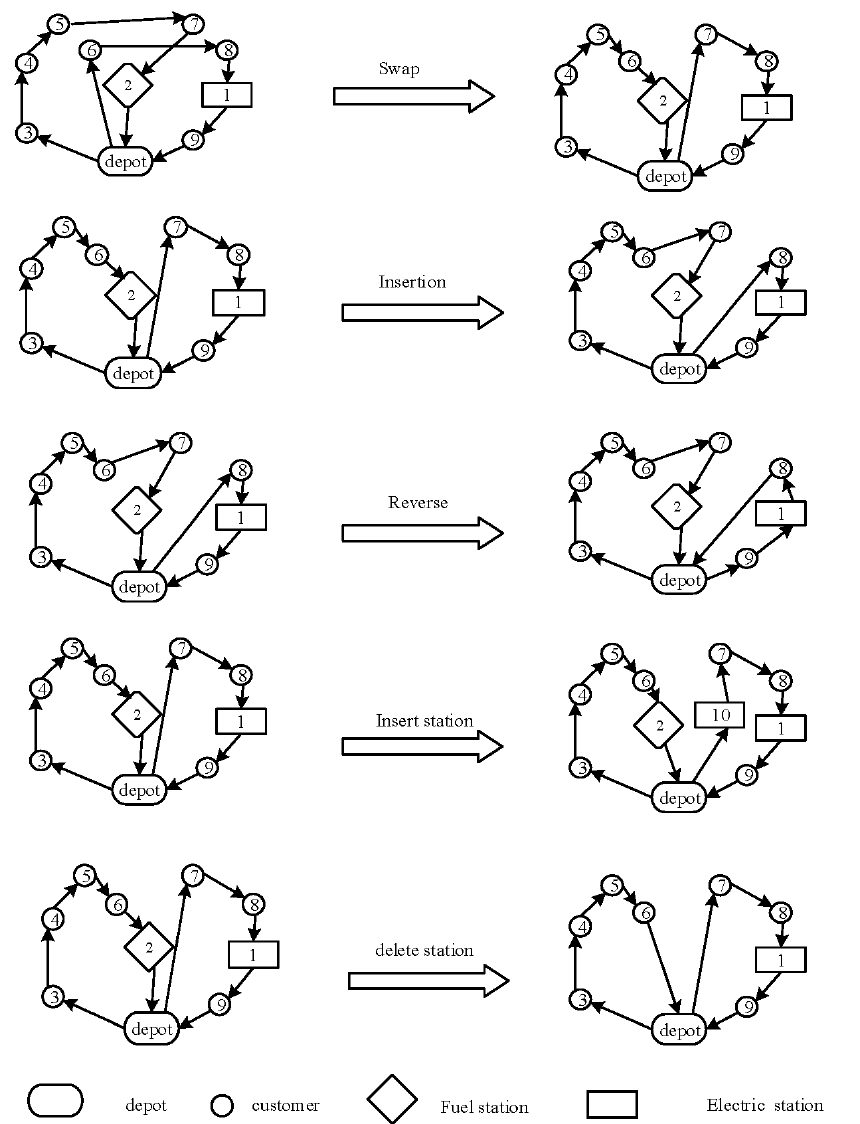
Figure 2. Neighborhood